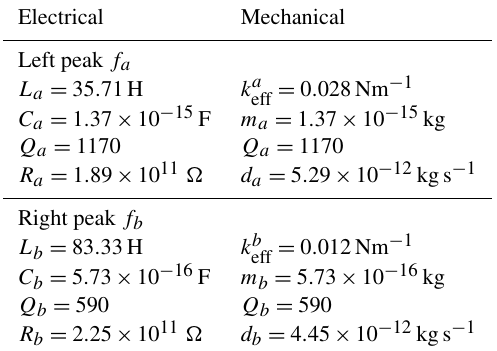
Table 5. Calculated values for the equivalent circuit model for both resonance peaks of the coupled system in Fig. 15b based on the properties given in Table